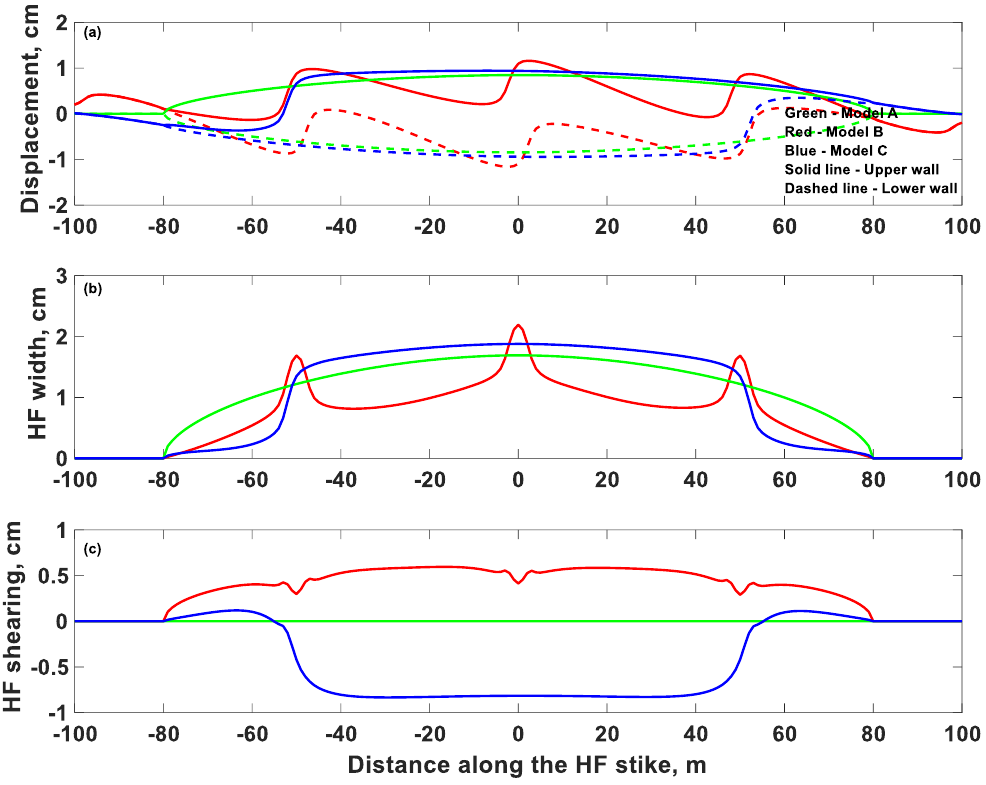
Figure 3—The top panel shows the displacements of the two HF walls in the three models; The middle panel shows the width profile along the HF; And the bottom panel shows the shearing profile along the